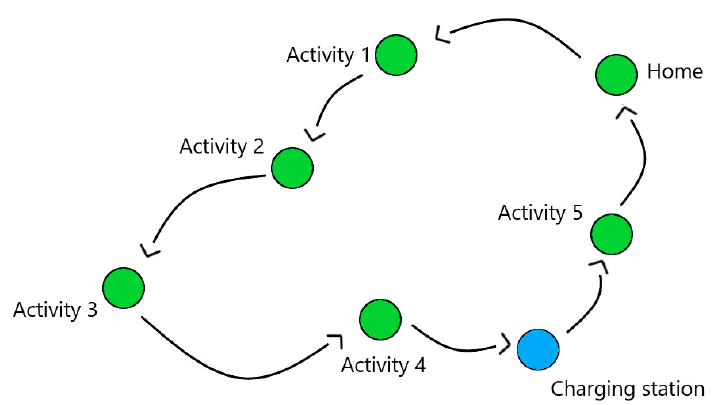
Figure 1. The classic charging scenario of the DACO-EV problem.